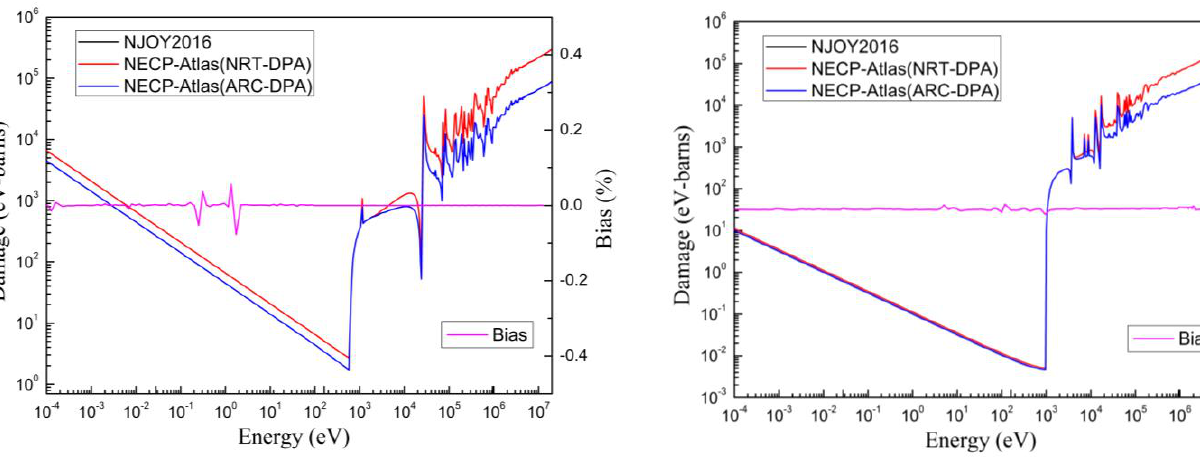
Figure 4. Radiation damage energy production Figure 5. Radiation damage energy production cross sections of Fe-56 cross sections of